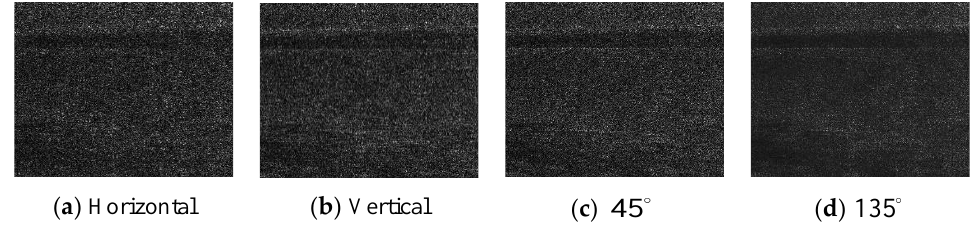
Figure 5. Gradient images of four directions of the rough sea images. ( a ) Horizontal direction; ( b ) vertical direction; ( c ) 45 direction; ( d ) 135